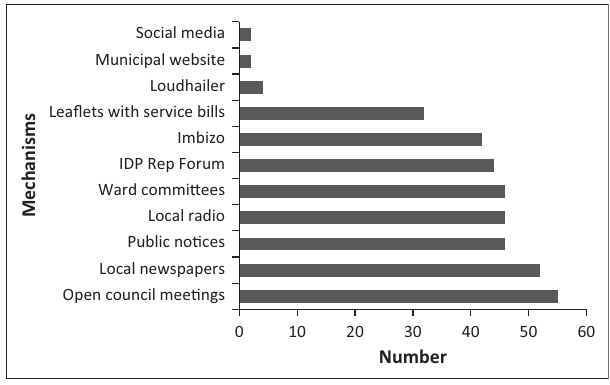
FIGURE 1: Perceived effectiveness of integrated development plans participation mechanisms.